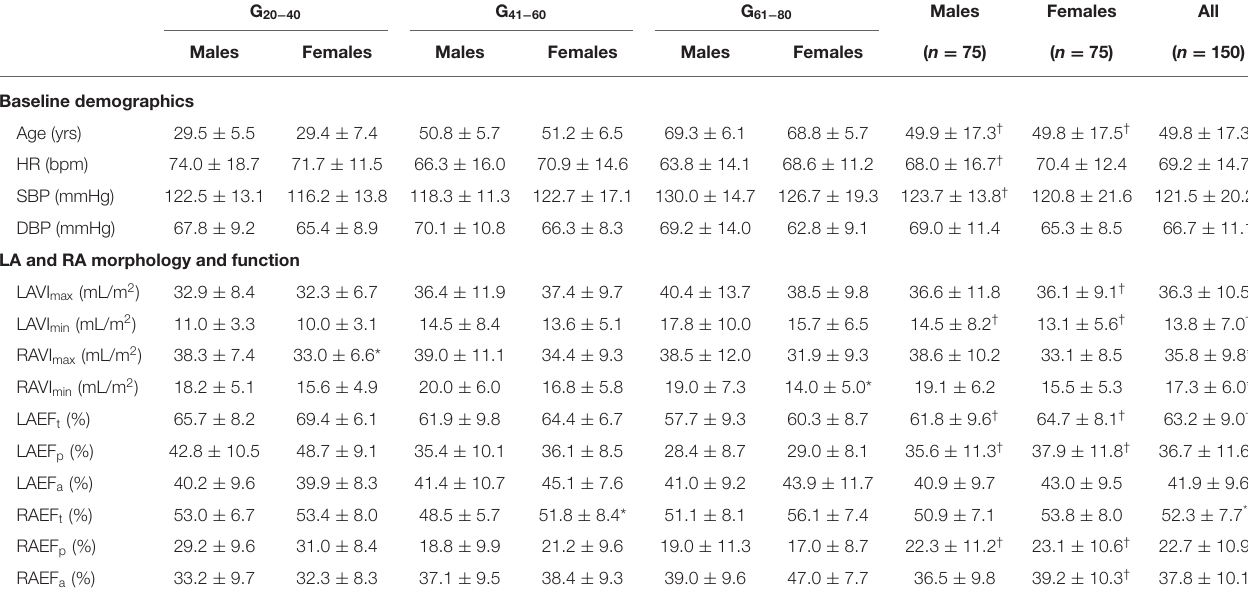
TABLE 1 | Baseline characteristics. G 20 − 40 G 41 − 60 G 61 − 80 Males Females All Males Females Males